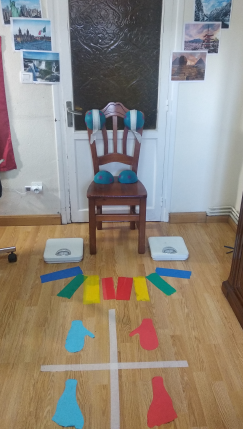
Figure 1. The setup of a patient’s room with the equipment on the wall and the floor for the rehabilitation